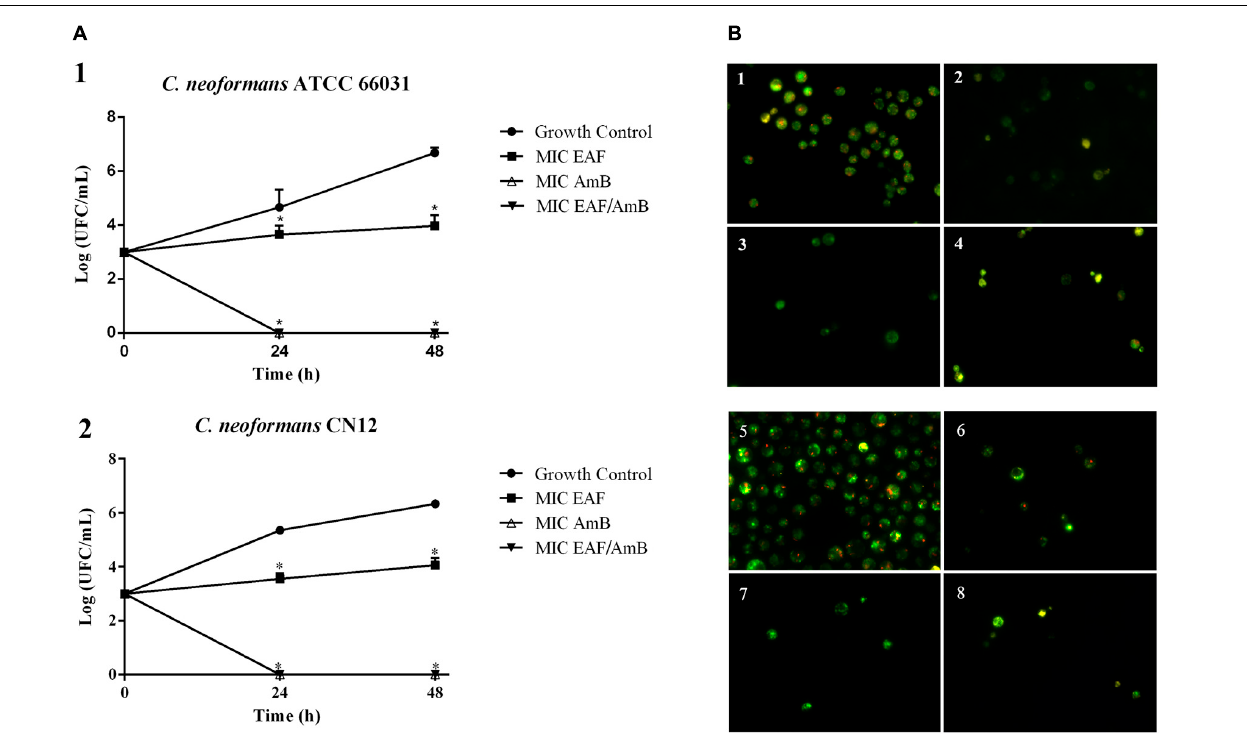
FIGURE 1 | Effect of ethyl acetate fraction (EAF) of Poincianella pluviosa bark and amphotericin B (AmB) alone or in combination against Cryptococcus neoformans . (A) Time-kill kinetics of EAF, AmB, and their combination at 0, 24, 48, and 72 h. (1) C. neoformans ATCC 66031; (2) C. neoformans CN12. The values are the mean ± standard deviation of two independent experiments in duplicate. Analysis of C. neoformans survival data was performed using two-way ANOVA, * p < 0.05. (B) Cell viability analysis of C. neoformans ATCC 66031 (1–4) and C. neoformans CN12 (5–8) by fluorescence microscopy using FUN-1 R (cid:13) dye. Yeasts were incubated with or without the minimal inhibitory concentrations (MICs) of the two compounds alone or combined for 12 h. Cells with diffuse greenish-yellow fluorescence characterize metabolically inactive cells, and cells containing red fluorescent structures in their vacuoles represent metabolically active yeast. (1,5) untreated viable cells; (2) 1,000.0 µ g/ml EAF; (3,7) 0.125 µ g/ml AmB; (4,8) 3.9/0.003 µ g/ml EAF/AmB; (6) 125.0 µ g/ml